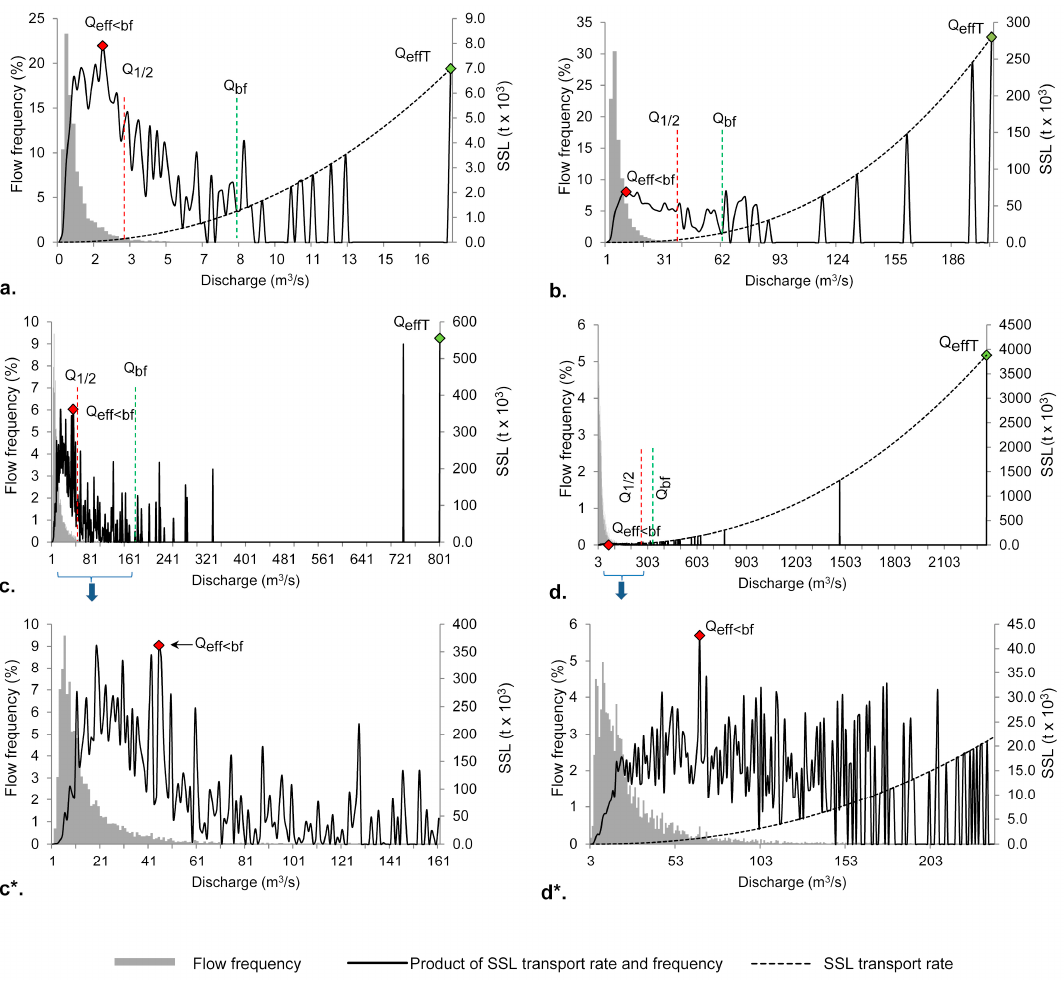
Figure 5. Examples of estimation of Q effT , Q eff<bf and Q 1/2 for suspended sediment transport using various methods: ( a ) Lunca de Sus—KDE; ( b ) Goioasa—SD/4; ( c , c* ) Târgu Ocna—RSSL; ( d , d* ) Vrânceni—EBM.